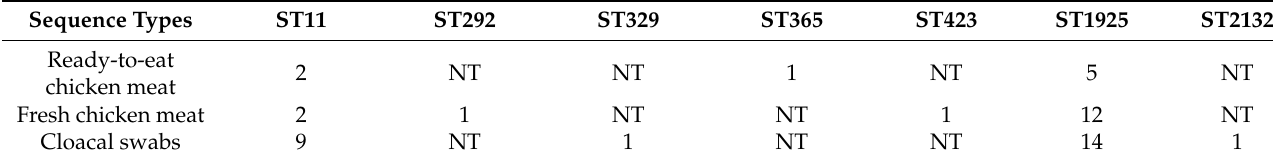
Table 4. MLST sequence types of Salmonella Enteritidis isolates.